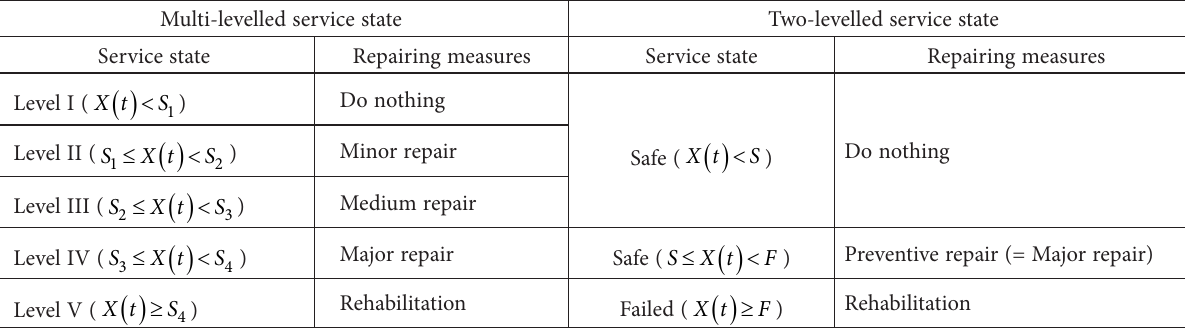
Table 2. SOM approach dealing with different classifications of service